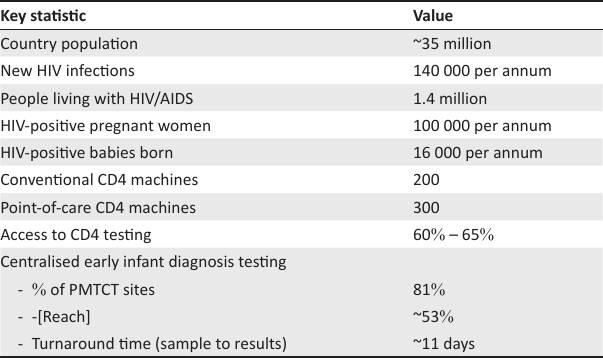
FIGURE 1: Key HIV statistics in Uganda, 2014, showing HIV prevalence by region. TABLE 1: Key HIV statistics in Uganda,